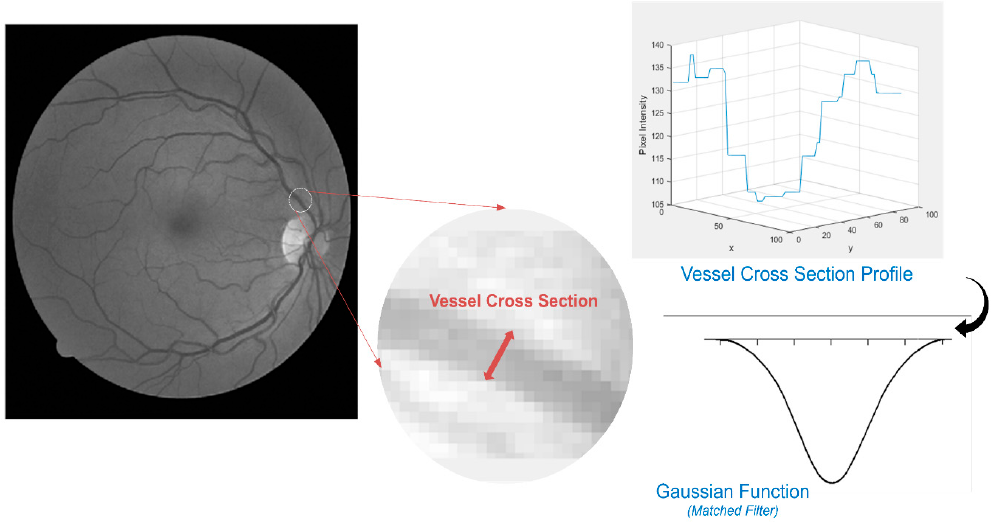
Figure 8. Cross-section intensity profile of the region marked by a straight line between point A and point B on retina image.